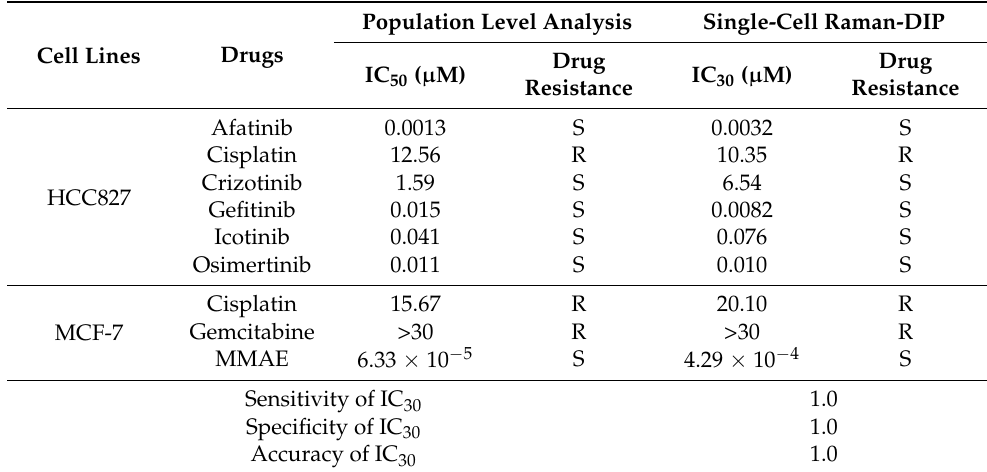
Table 1. The IC 50 and IC 30 ( µ M) of different chemotherapy drugs and their drug resistance.